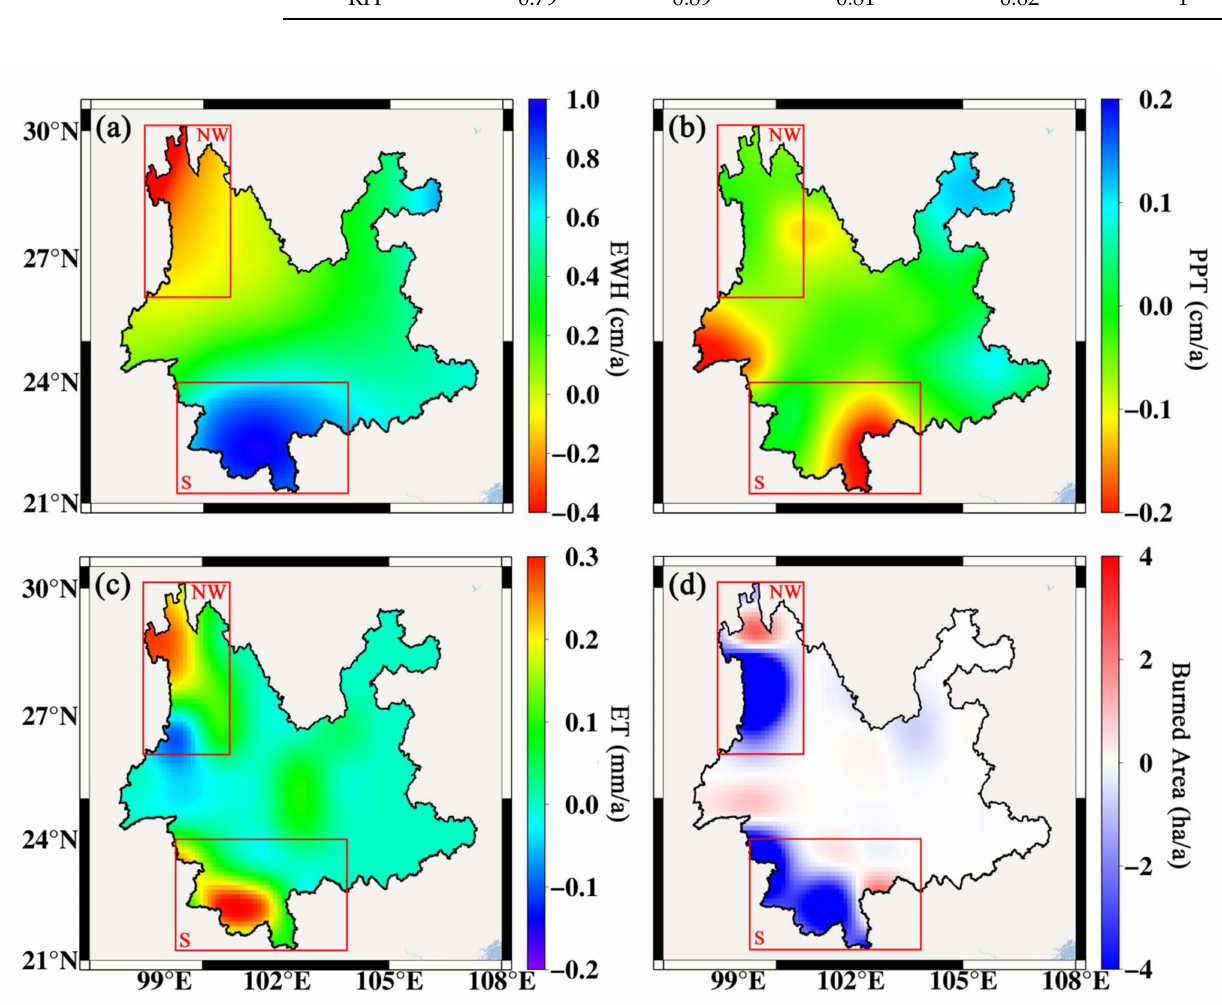
Figure 8. The spatial distribution of long-term trend change of GRACE TWSC ( a ), PPT ( b ), ET ( c ) and burned area ( d